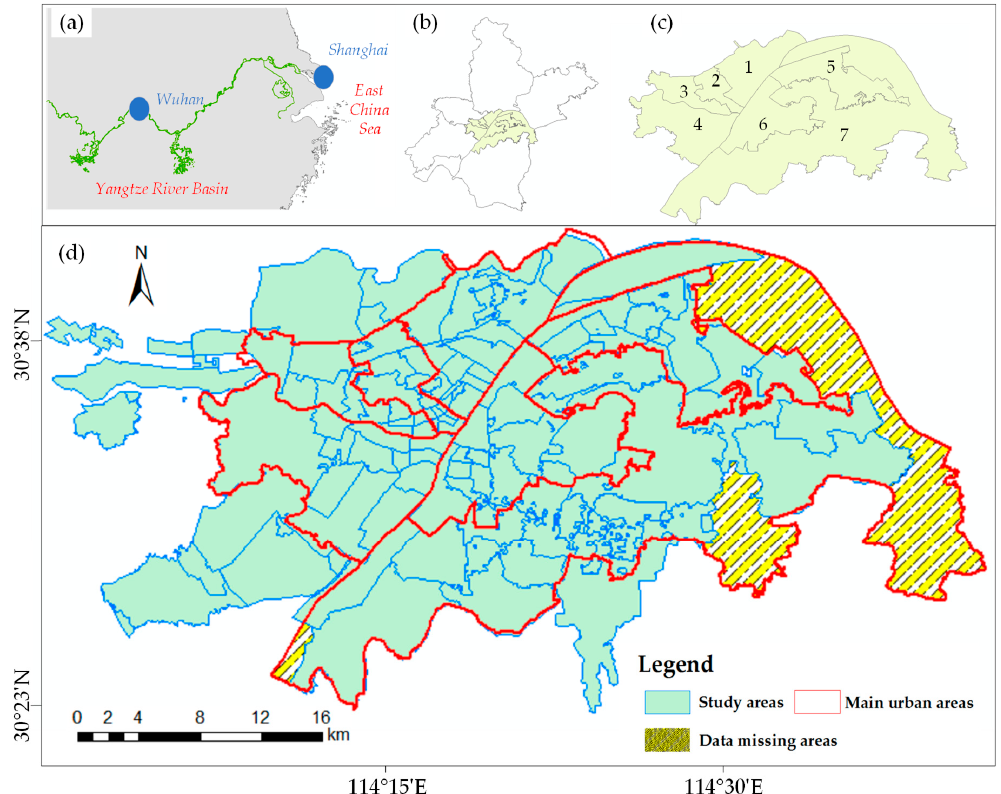
Figure 1. ( a ) Location of Wuhan in the Yangtze River Basin. ( b ) Administrative division of Wuhan in the municipal district level. ( c ) Seven districts in the main urban areas of Wuhan (from one to seven): Jingan, Jianghan, Qiaokou, Hanyang, Qingshan, Wuchang, and Hongshan. ( d ) 113 subdistricts selected as our study areas.